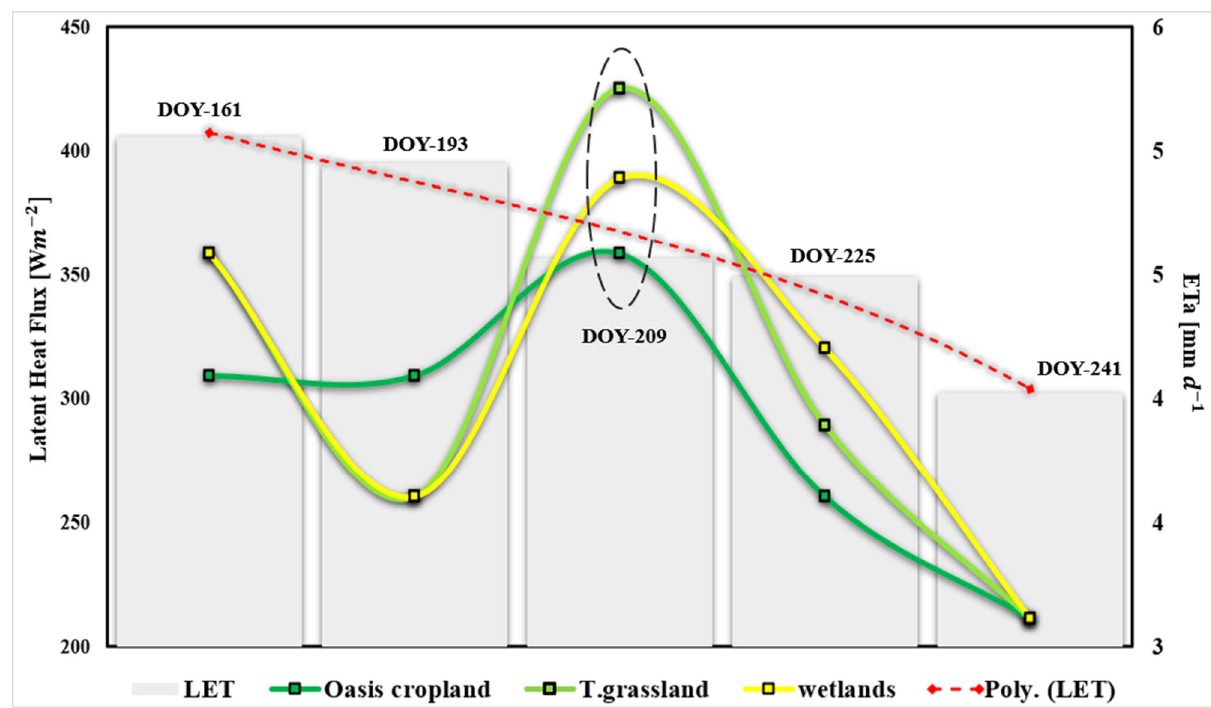
Figure 14. The trend of mean ETa estimates of vegetated patches against the average latent heat of evapotranspiration over time. (The black dotted line shows the peak of summer warmth, while the dotted red line represents the polynomial trend of LET).